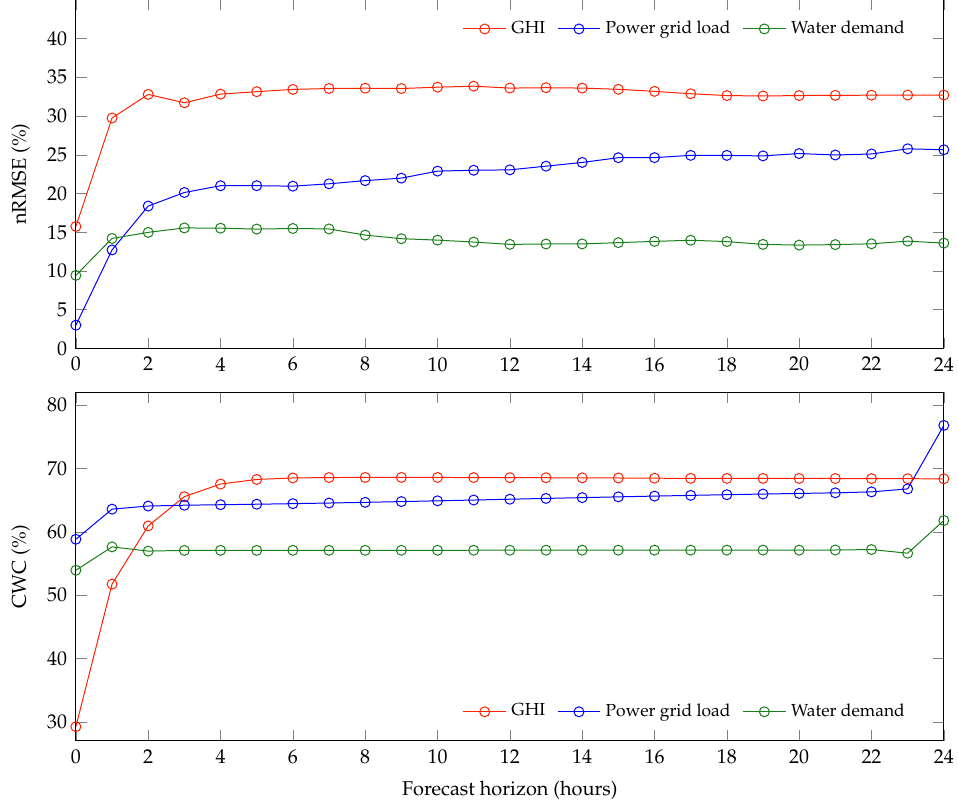
Figure 2. Evaluation criteria (nRMSE (19) and CWC (22)) for intraday GPR forecasts of GHI, power grid load and water demand, with respect to the forecast horizon, over a one-week